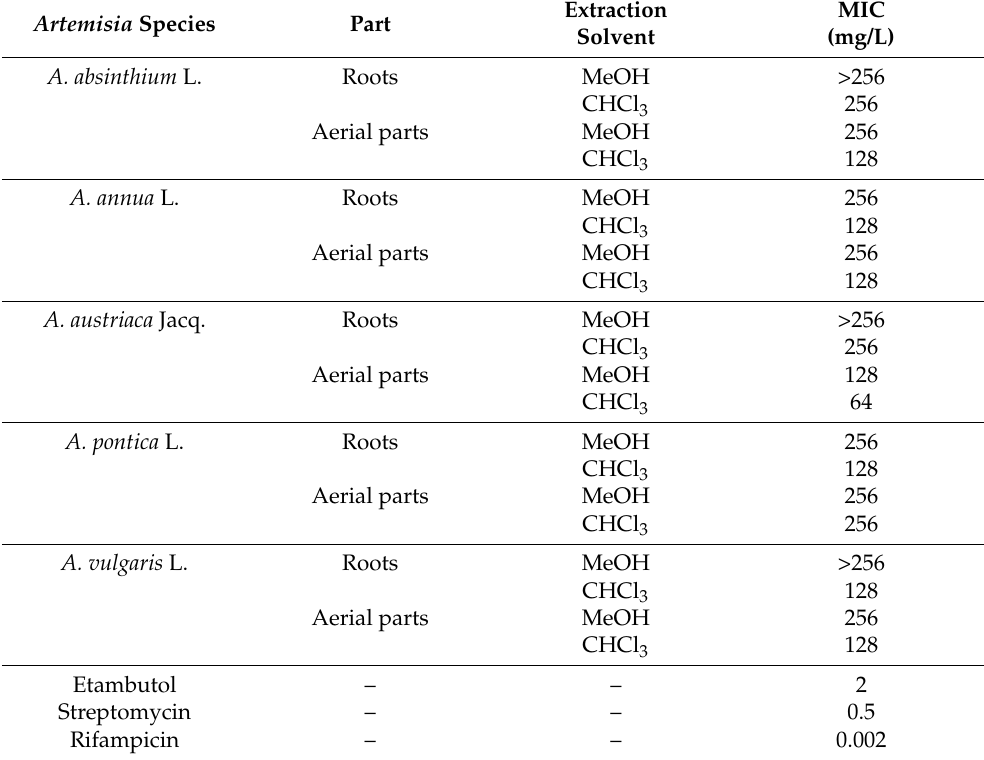
Table 5. Anti- Mycobacterium tuberculosis H37Ra activity of Artemisia spp. extracts. Artemisia Species Part